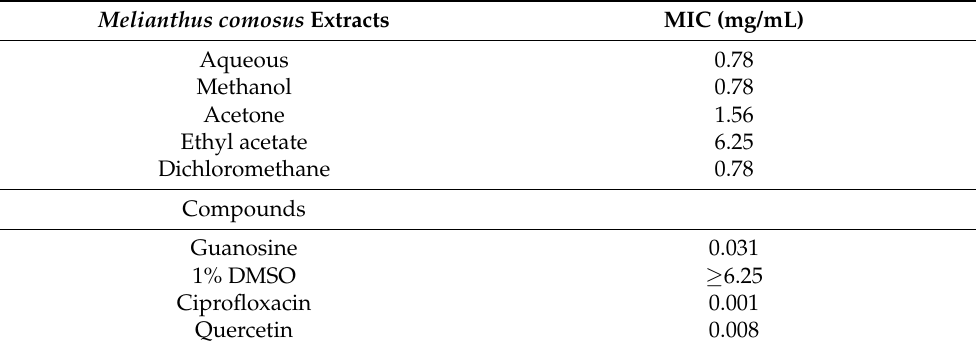
Table 2. Melianthus comosus crude extract including guanosine and their minimum inhibitory concen- trations (MIC) against Pseudomonas aeruginosa